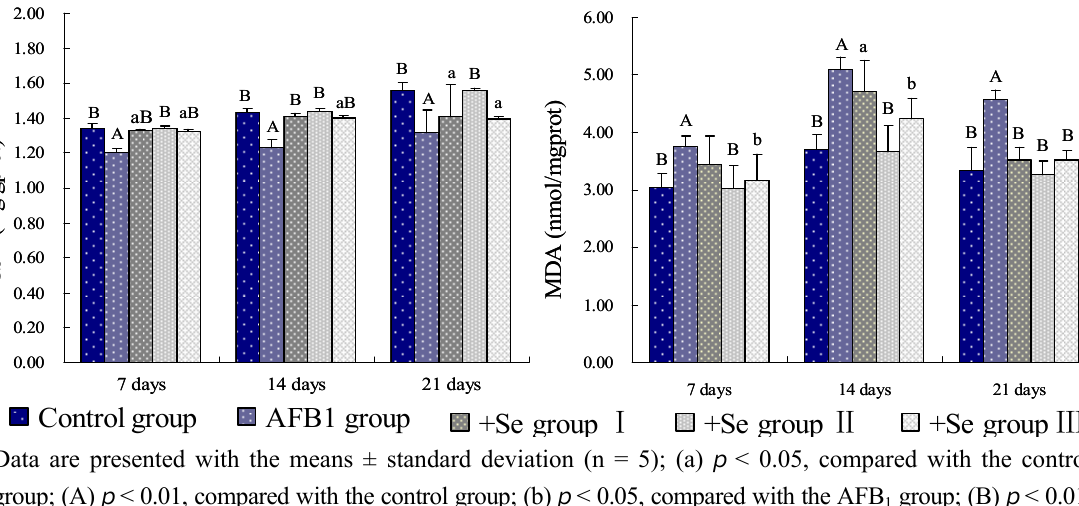
group; (B) p < 0.01, 1